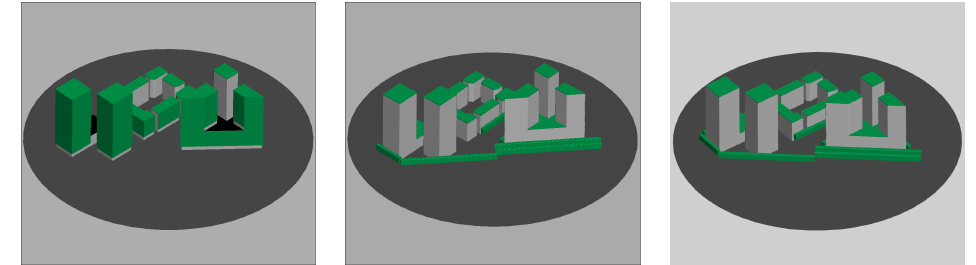
Figure 2. Computational domain: ( a ) Test Case 1 and ( b ) Test Case 2. Computational mesh for Test Case 2: ( c ) without vegetation, ( d ) with green roofs, ( e ) with green walls and ( f ) with